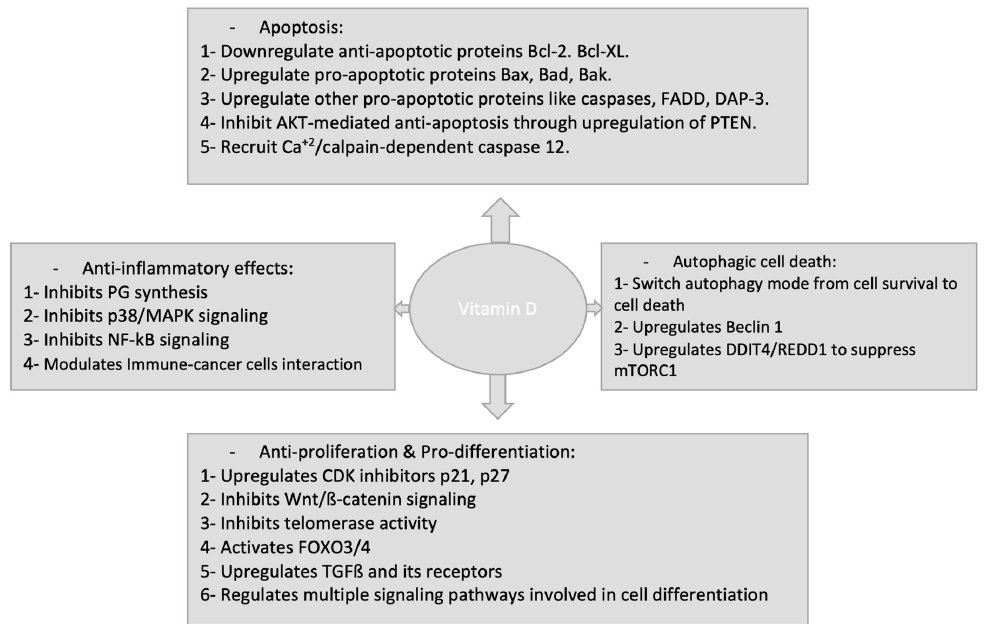
Figure 2. Anti-tumour effects of Vitamin D and its analogues.